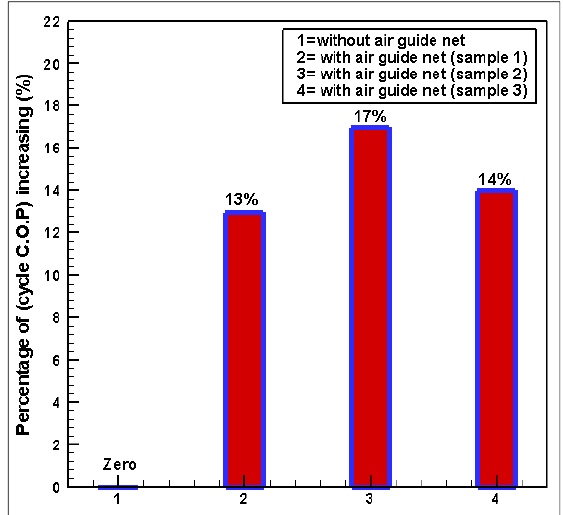
Fig. 7. Graphical representation of cycle C.O.P percentage increasing for the